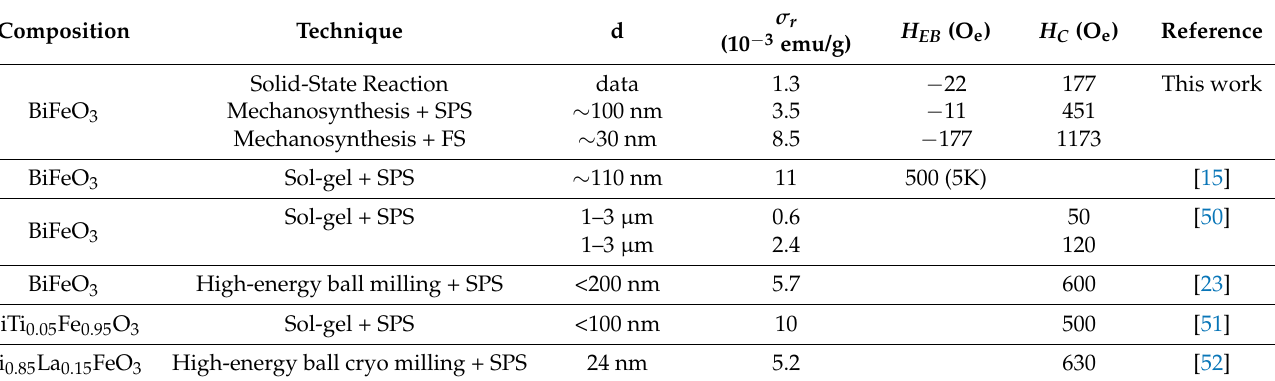
Figure 6. ( a ) Magnetic hysteresis loops of the studied specimens taken at 300 K. ( b ) Low field re- of the hysteresis loops. gion of the hysteresis loops. Table 1. Magnetic properties of BFO-based bulk ceramics sintered by electric field